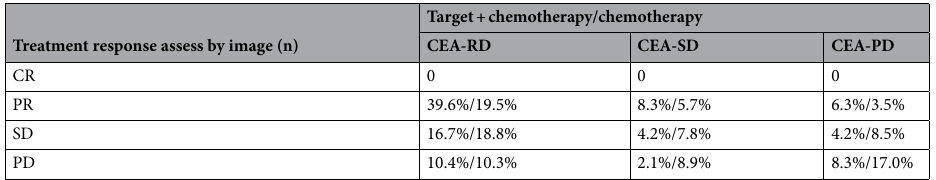
Table 4. Combined target therapy or not and the correlation with the treatment response by the image and the CEA. CR complete response, PR partial response, SD stable disease, PD progressive disease, CEA-RD response disease by CEA, CEA-SD stable disease by CEA, CEA-PD progressive disease by CEA.